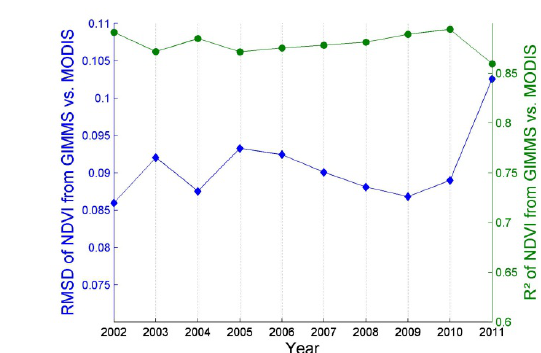
Figure 7. Agreement/disagreement between weekly GIMMS and MODIS NDVI values. ( left ) Intra-annual analysis; ( right ) inter-annual analysis. (solid green) coefficient of determination (R²), (blue) root mean square difference (RMSD), (dashed green) time course of the average NDVI. Per week, or year, one value is shown per indicator. Lines are only shown for reader’s